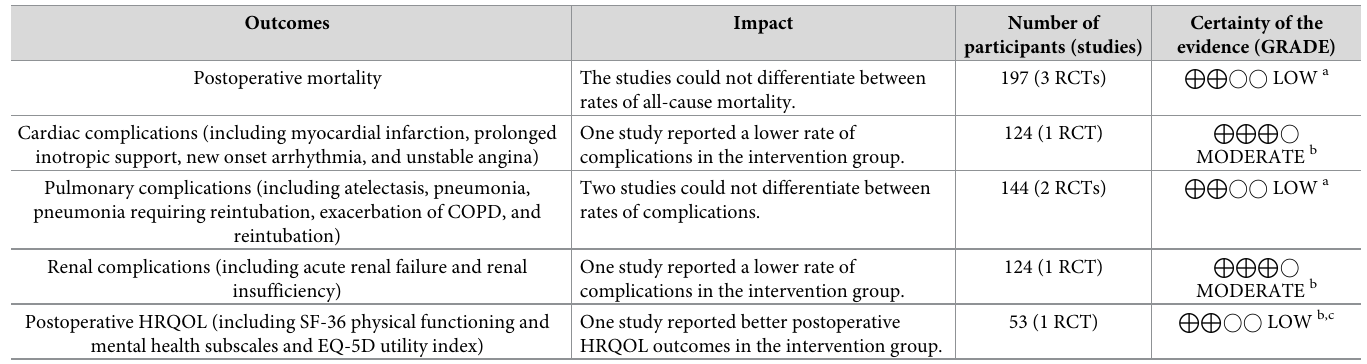
Table 4. Summary of